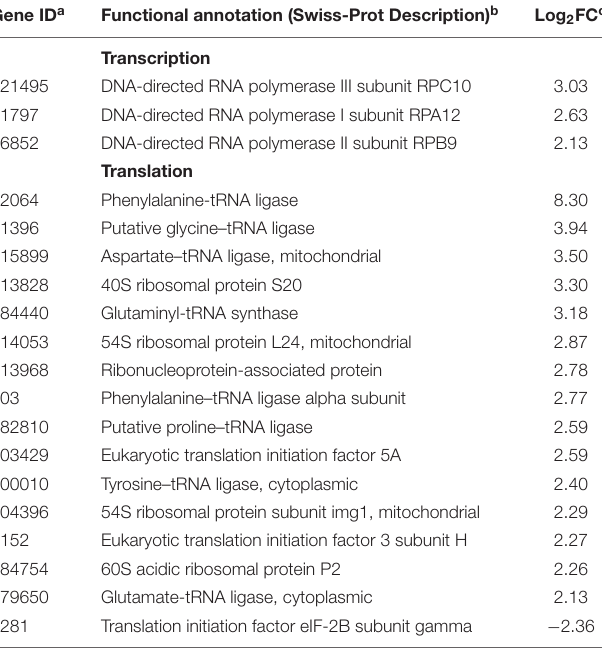
TABLE 3 | The DEGs related to protein synthesis in strain LZ117*. TABLE 4 | The DEGs related to protein folding, sorting and degradation in strain